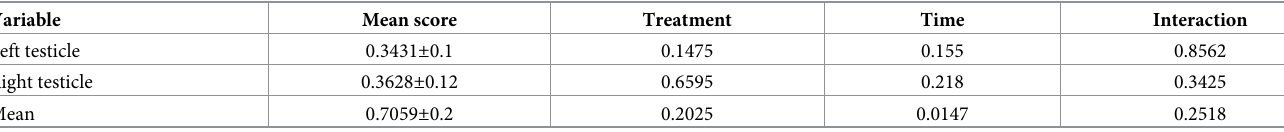
Table 4. The mean score, the standard error mean, and p values of the duplex B-mode ultrasound data. Variable